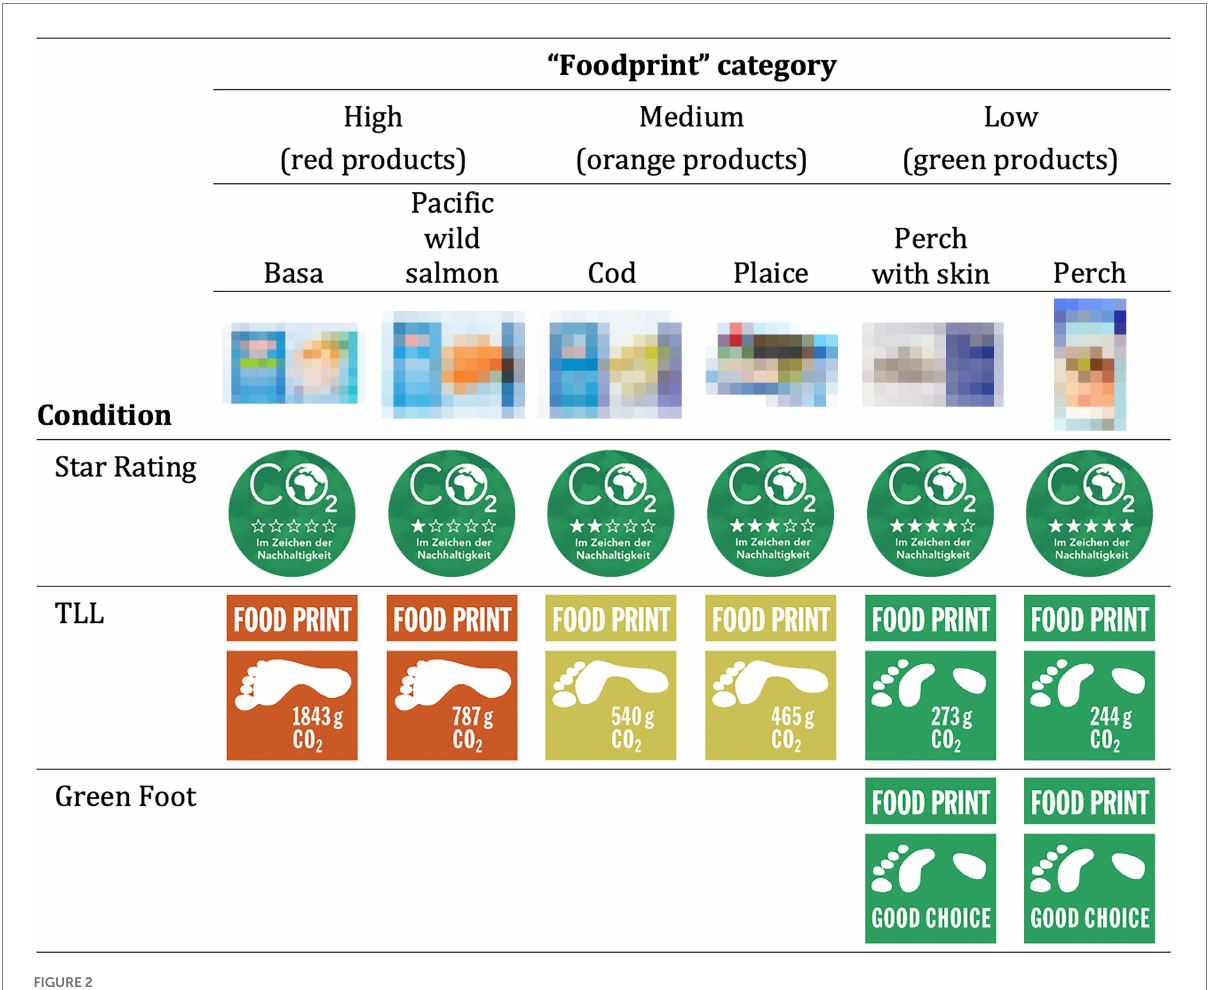
FIGURE 2 Example of the three different labels tested in the product category